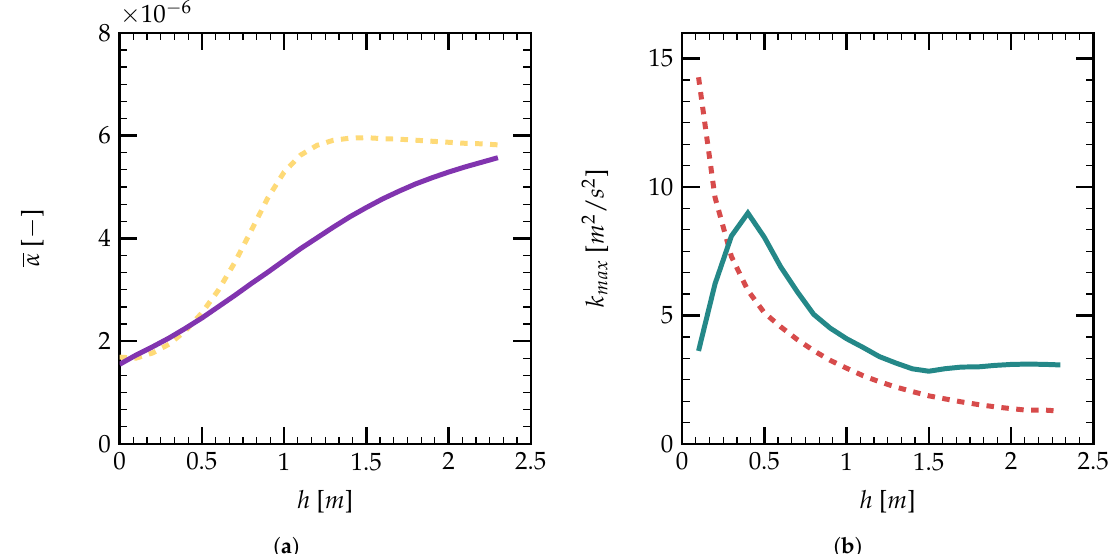
Figure 13. ( a ) Evolution of the surface-averaged droplet volume fraction α as a function of h ; monodisperse spray ( ), polydisperse spray ( ); ( b ) Evolution of k max at different vertical surfaces as a function of the vertical distance; monodisperse spray ( ), polydisperse spray (